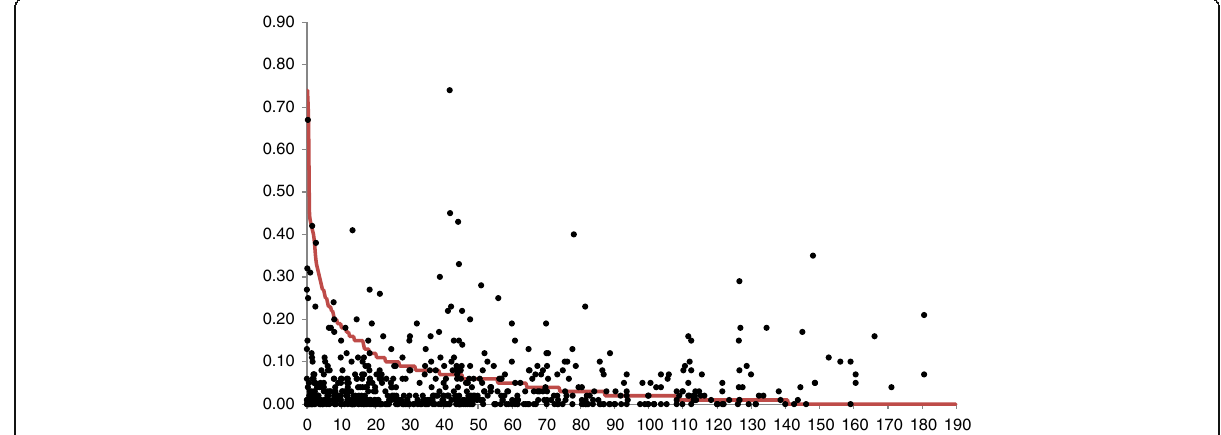
Fig. 2 Distribution LD (R 2 ) values observed between linked SSR marker pairs as a genetic distance in centiMorgans